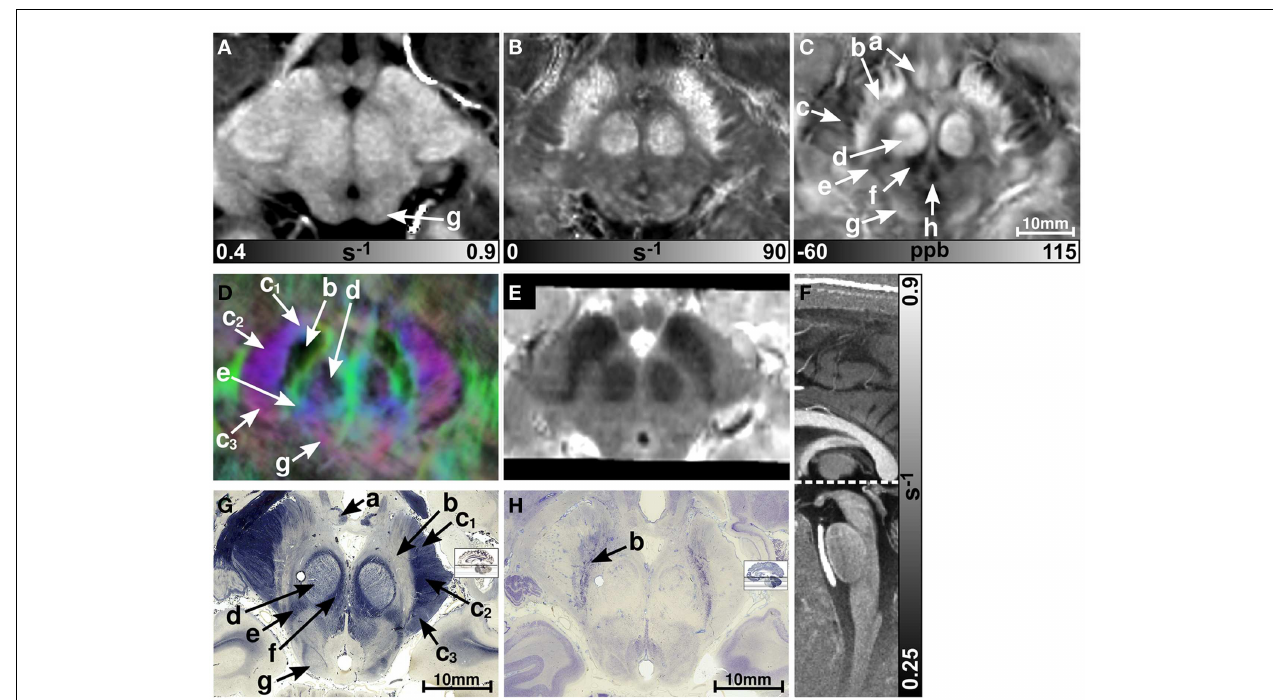
histological sections from a different subject stained for myelin and cells are , and susceptibility maps as well FIGURE 1 | Images of the midbrain . R 1 , R ∗ 2 illustrated in (G) and (H) , respectively.The arrows in the images indicate: (a) as direction-encoded track-density and T 2 -weighted images of the same brain mammillary body, (b) substantia nigra, (c) crus cerebri, (c 1 ) corticobulbar region are presented in axial orientation from (A–E) , respectively. Red, blue, fibers, (c 2 ) corticospinal fibers, (c 3 ) corticopontine fibers, (d) red nucleus, (e) and green in the track-density image represent anisotropy along medial lemniscus, (f) central tegmental tract, (g) inferior colliculus, and (h) medial-lateral, superior-inferior, and anterior-posterior directions, respectively. medial longitudinal fasciculus. [The histological stains (G,H) were adapted Note that the track-density image is slightly distorted compared to the other with permission from http://www.brains.rad.msu.edu and image contrasts (A–C,E) .The sectional plane of the axial images is indicated http://brainmuseum.org, supported by the US National Science Foundation.] by the dashed line overlaid on the sagittal R 1 map shown in (F) . Axial